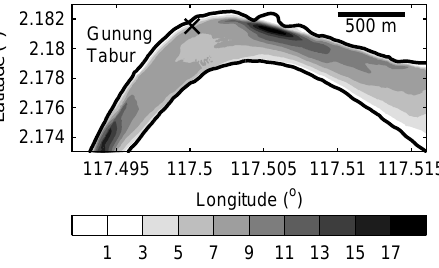
Fig. 3. Bathymetry of the Berau River close to the village Gunung Tabur showing depths with respect to mean water level (m). Instru- ments that obtain flow velocity and suspended sediment concentra- tion were deployed at the location marked with an